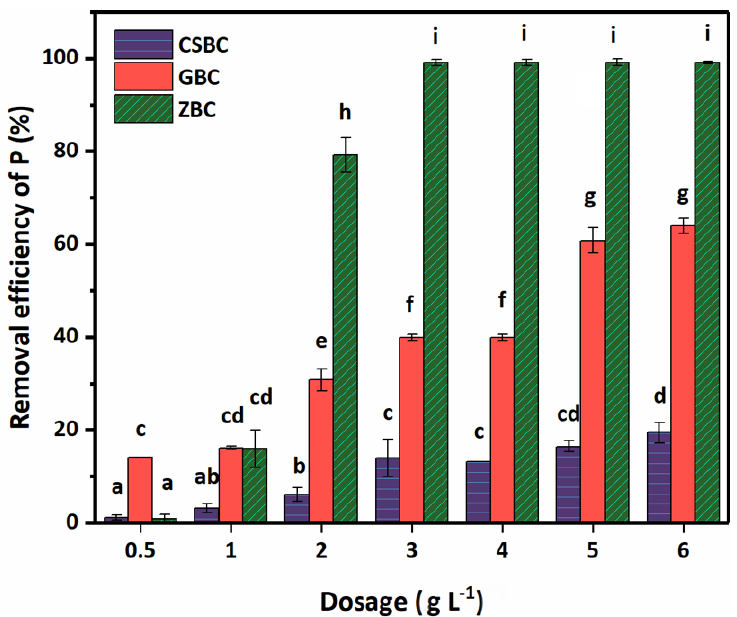
Figure 6. Effects of different dosages on the P adsorption by CSBC, GBC, and ZBC. (P initial concentration: 15 mg L − 1 ; adsorption time: 4 h; pH: 6; temperature: 25 °C; ionic strength: 0.01 M.)